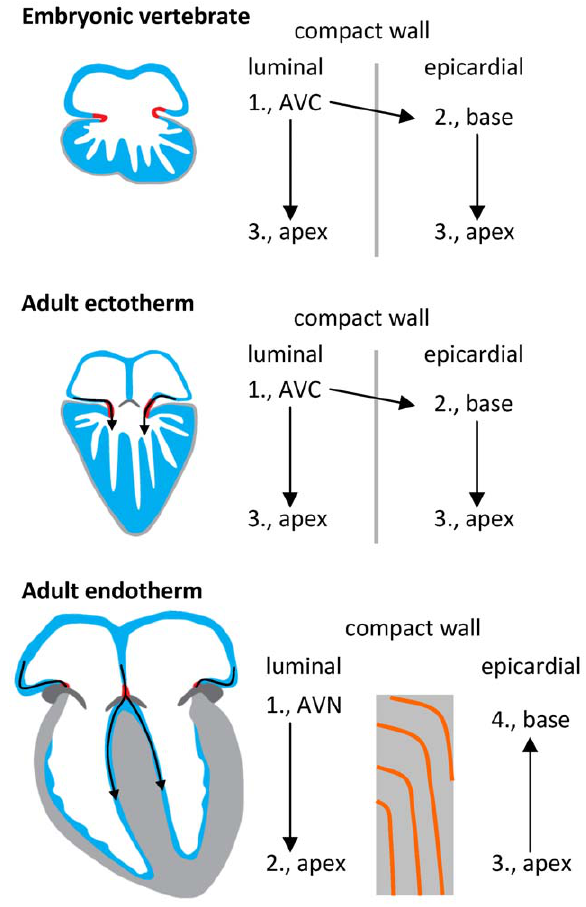
Figure 10. The trabecular myocardium is activated from base to apex in all vertebrates. (A–C) The trabecular myocardium gives rise to the His-Purkinje system in mammals and birds and remains activated from base to apex. (C) On the epicardial surface of septated and thick-walled ventricles, as in the formed hearts of mammals and birds, activation is seen to occur from apex to base and the luminal base-to-apex activation is obscured.